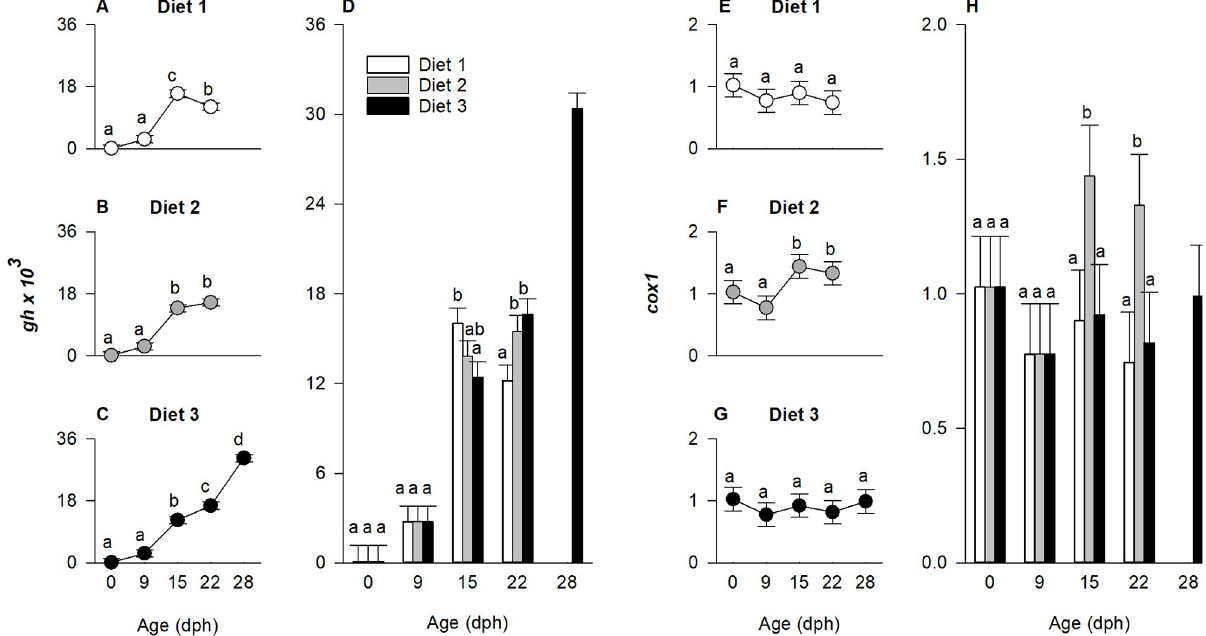
Fig 7. Effect of age (days post hatch (dph)) and treatment (diet) on relative expression of growth hormone ( gh ) and cytochrome c oxidase ( cox1 ) in European eel, Anguilla anguilla , larvae. Values represent means ( ± SEM), while different lower-case letters represent significant differences (p < 0.05).